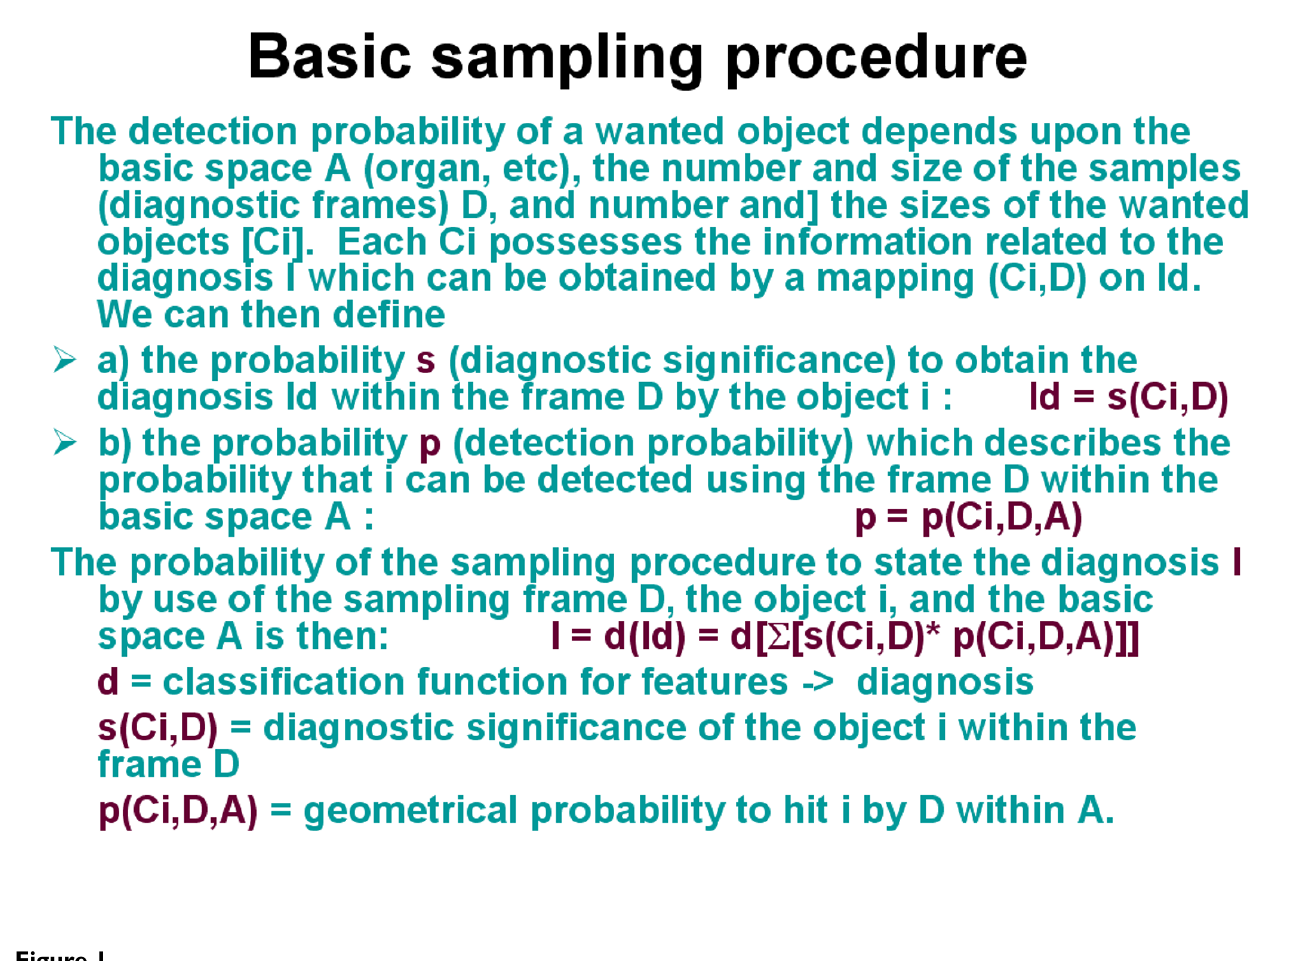
Survey of sampling algorithm Figure 1